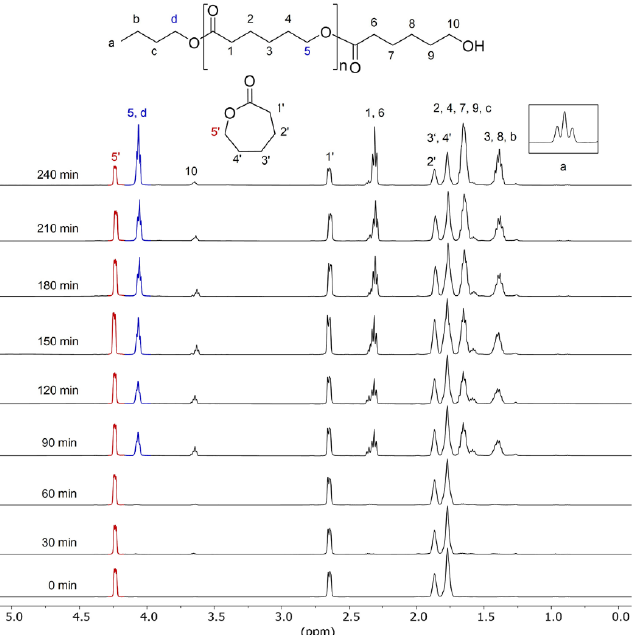
Figure 3. 1 H-NMR spectra (500 MHz, CDCl 3 ) of the crude PCL obtained from the ROP of CL catalyzed by 0.50 mol% of 1,4- bis [Bim][PF 6 ] ( 2a ) and 1.0 mol% of n C 12 H 25 OH at 150 °C for 4 h.